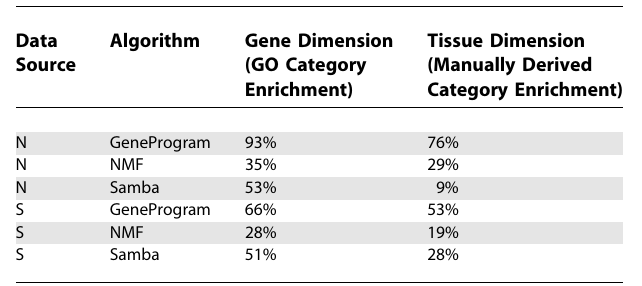
Table 1. GeneProgram Outperformed Two Popular Biclustering Algorithms, an NMF Implementation and Samba, in Recovering Biologically Interpretable Gene Sets from Two Compendia of Mammalian Gene Expression